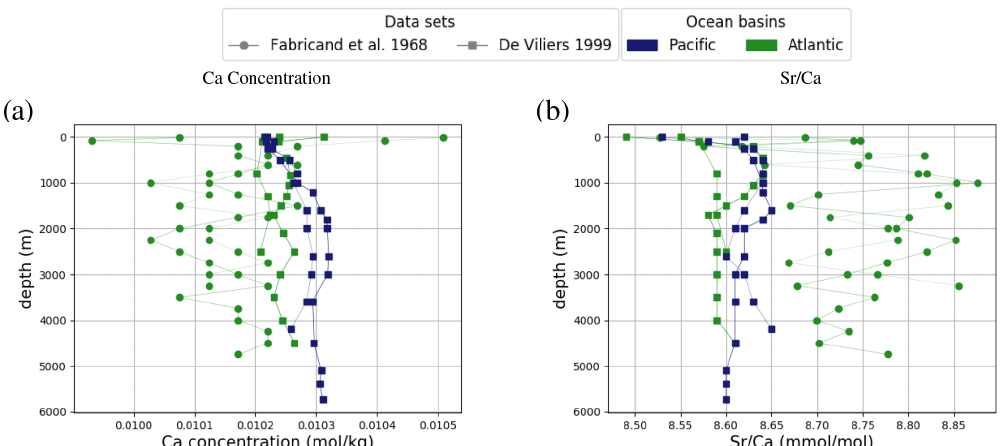
Figure F4. Composites of all available ocean Ca concentration (a) and Sr/Ca profiles (b) . Data are taken from Fabricand et al. (1967) and De Villiers (1999). Ca concentrations are normalized to a salinity of 34.90.